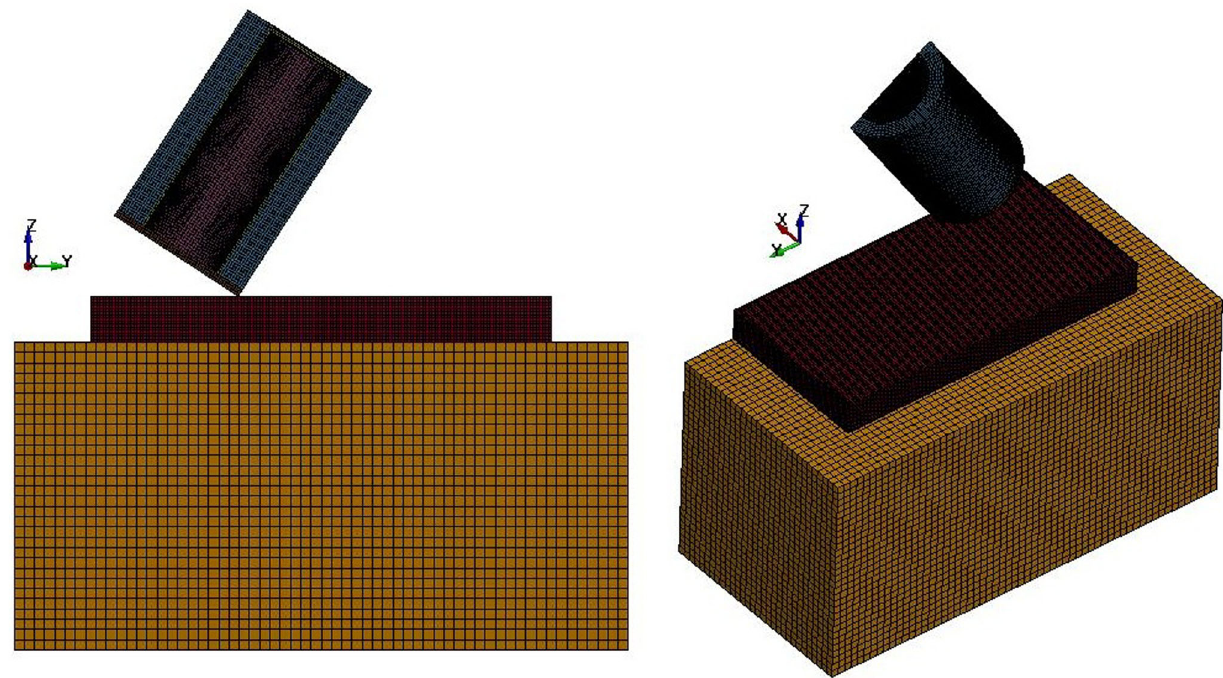
Fig. 15 Initial condition in tip-over simulation for 1/3-scale cask (number of elements = 266,830 and number of nodes = 304,329).